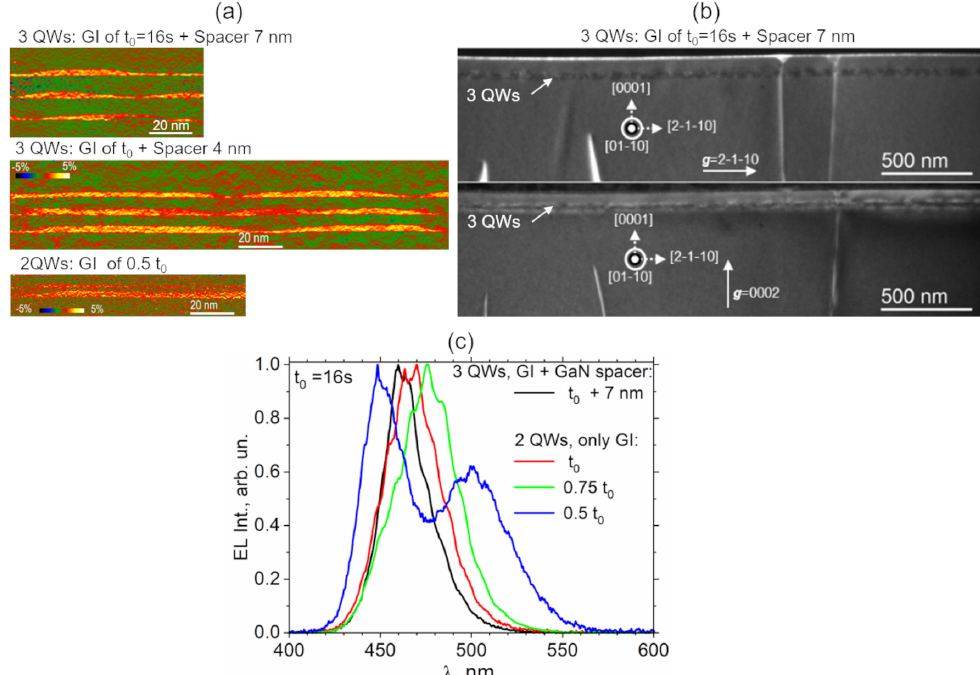
Figure 1. ( a ) Maps of vertical strain in InGaN vertically coupled islands obtained by dark-field electron holography in high-resolution mode. Upper image: three InGaN QWs, Gi t = 16 s, 7-nm GaN spacer. Middle image: three InGaN QWs, Gi during t = 16 s, 4-nm GaN spacer. Bottom image: two InGaN QWs, GI of 8 s, no intentional GaN spacer. ( b ) WBDF cross-sectional (01-10) images taken with g = 2-1-10 and g = 0002 of the same zone of the structure containing three QWs layers each subjected to a GI of 16 s and separated by a GaN spacer of 7 nm. ( c ) Normalized electroluminescence spectra from two InGaN QWs structures subjected to different time of GI compared to three InGaN QWs structure with a 7-nm-thick GaN spacer. Note two peaks in the spectrum of two InGaN QWs structure with GI of 8